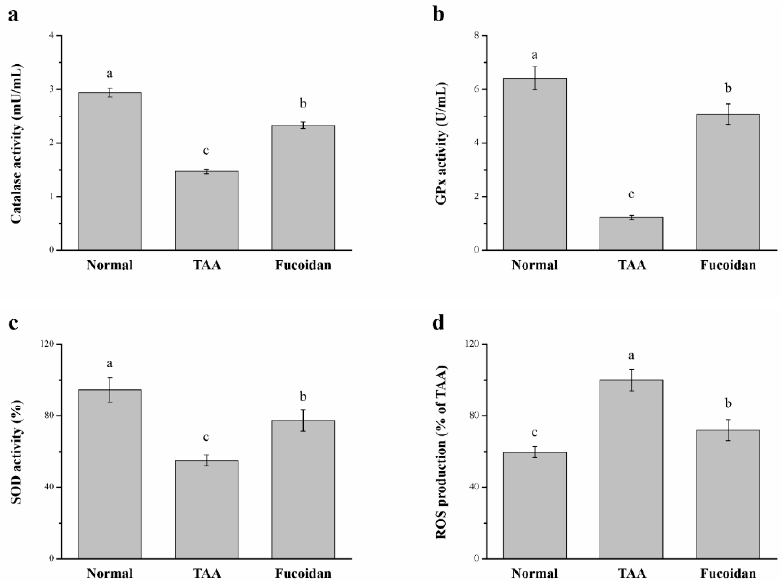
Figure 7. Changes of the hepatic ( a ) catalase activity, ( b ) glutathione peroxidase (GPx) activity, ( c ) superoxide dismutase (SOD) activity, and ( d ) reactive oxygen species (ROS) levels in normal mice, mice with TAA-induced liver injury, and fucoidan-treated mice with TAA-induced liver injury over a period of 42 days. All data are presented as the means ± SEMs ( n = 10). a–c Data with different letters in the columns are significantly different with one-way ANOVA, and the means of different groups were compared by Duncan’s test at p < 0.05.